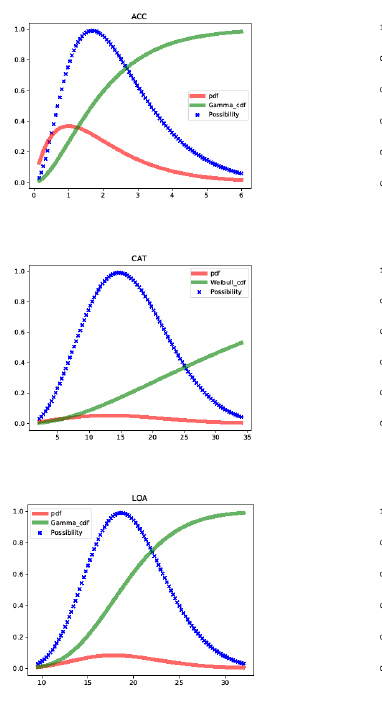
Fig. 4. Transformation Result for Process